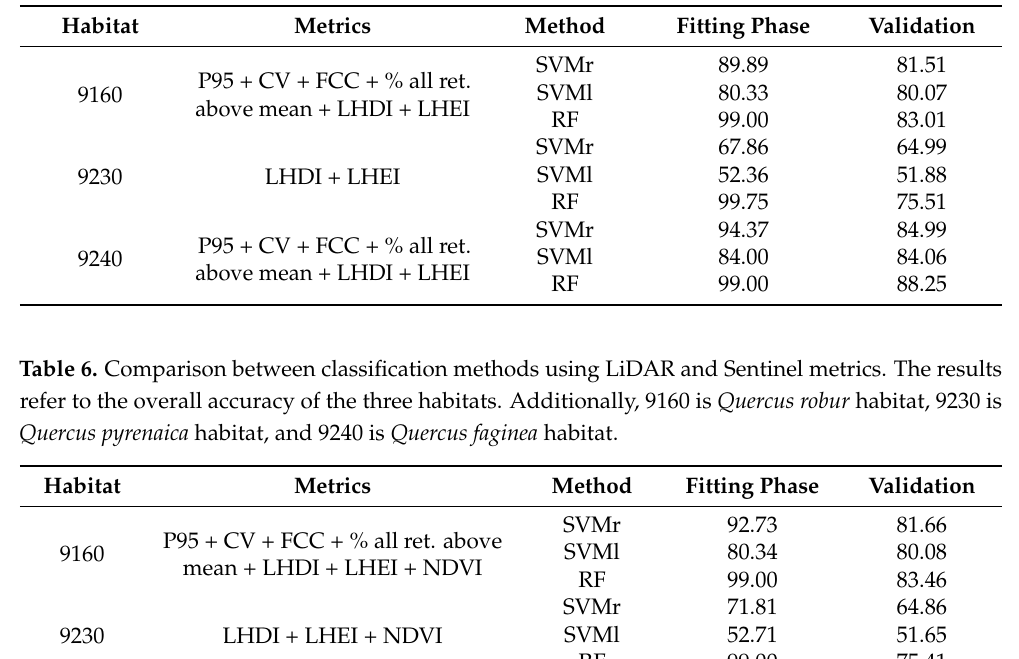
Table 5. Comparison between classification methods using LiDAR metrics. The results refer to the overall accuracy of the three habitats. Additionally, 9160 is Quercus robur habitat, 9230 is Quercus pyrenaica habitat, and 9240 is Quercus faginea habitat.